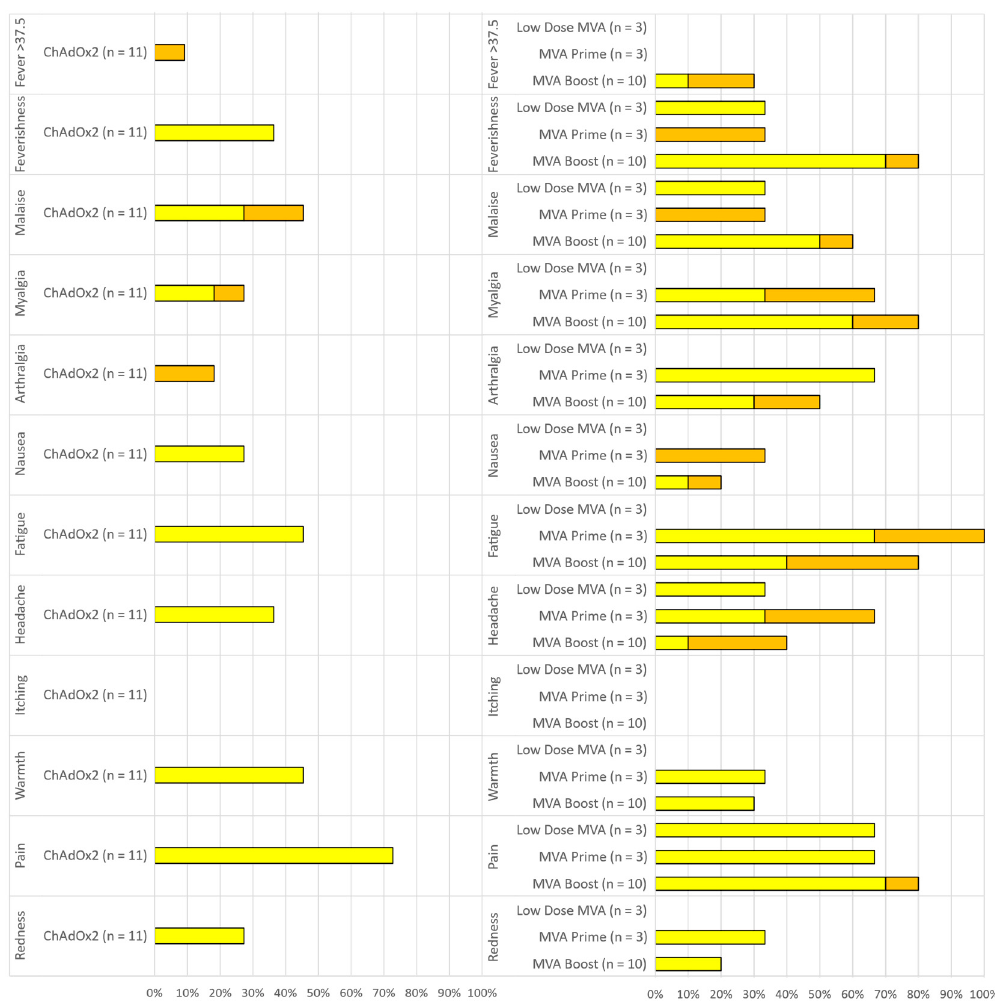
Figure 2. Reactogenicity of ChAdOx2 HAV prime ( left ) and Modified Vaccinia Ankara (MVA) HAV single or booster dose ( right ). Percentage of participants reporting solicited local and systemic adverse events (AEs) within 7 days of vaccination. Yellow = mild. Orange = Moderate. Low dose MVA = Group 4 (MVA 2 × 10 7 pfu prime only), MVA prime = Group 5 (MVA 2 × 10 8 pfu prime only), MVA Boost = Group 6 (MVA 2 × 10 8 pfu boost, 56 days after a 5 × 10 10 vp ChAdOx2 prime).